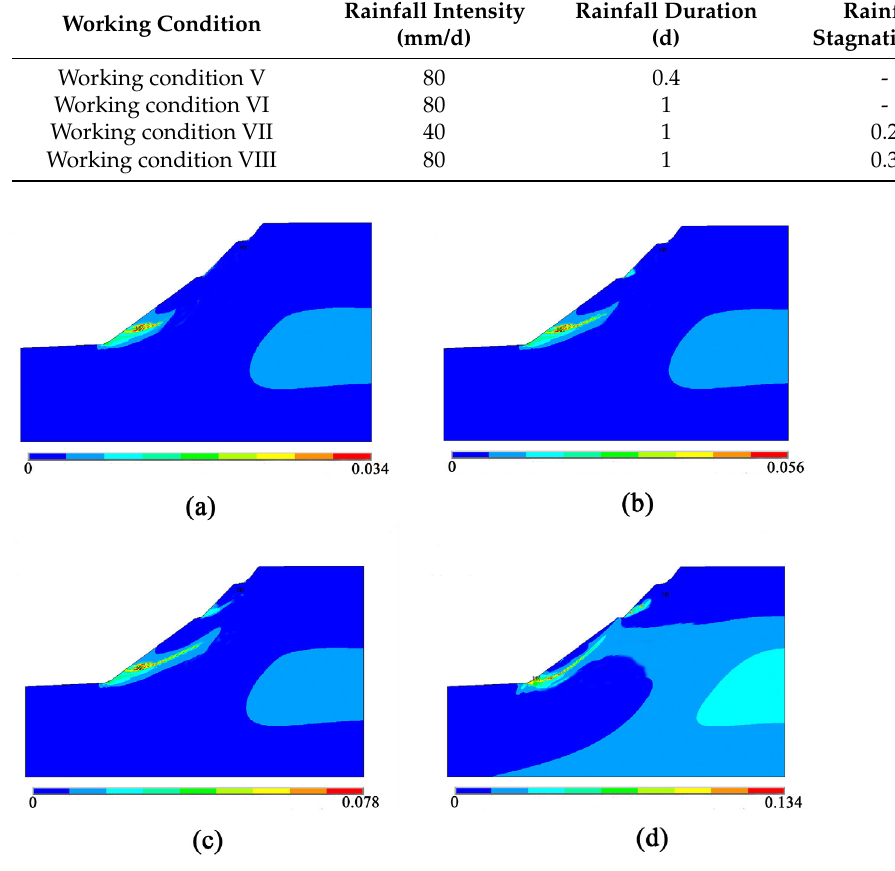
Figure 7. Plastic strain diagrams. ( a ) Working condition V; ( b ) Working condition VI; ( c ) Working condition VII; ( d ) Working condition VIII.